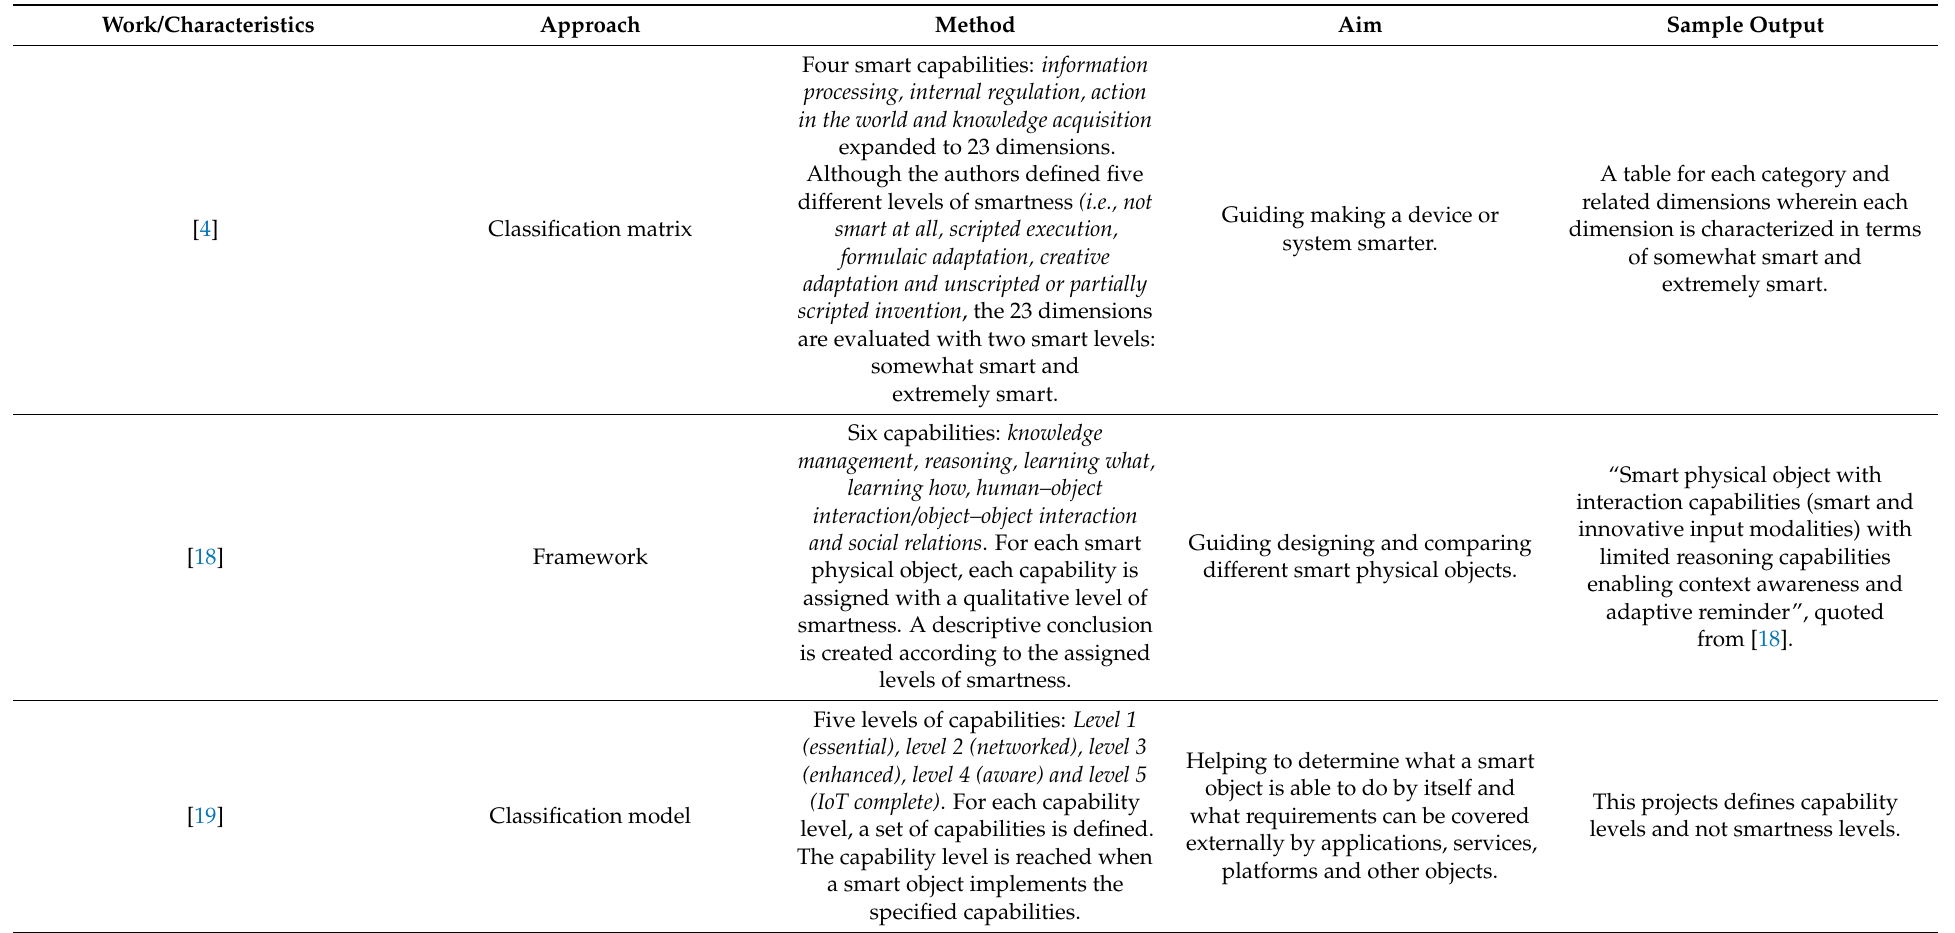
Table 1. Summary of the existing works aimed at classifying or segmenting smart artifacts in some